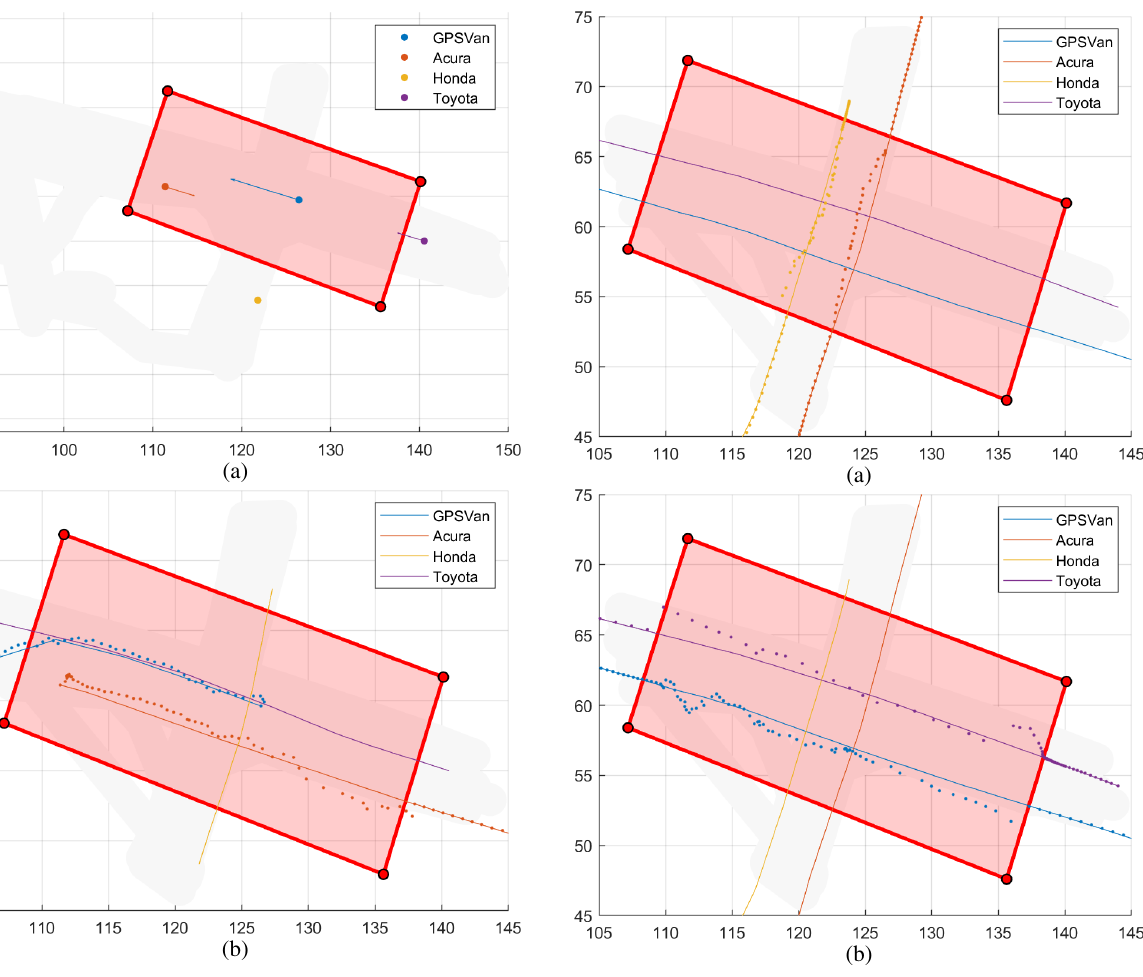
Figure 8. Case study 3: (a) vehicle starting configuration, (b) Figure 10. Reference (solid lines) and estimated (circular marks) vehicle tracks. vehicle tracks in case study 4a (a), and 4b